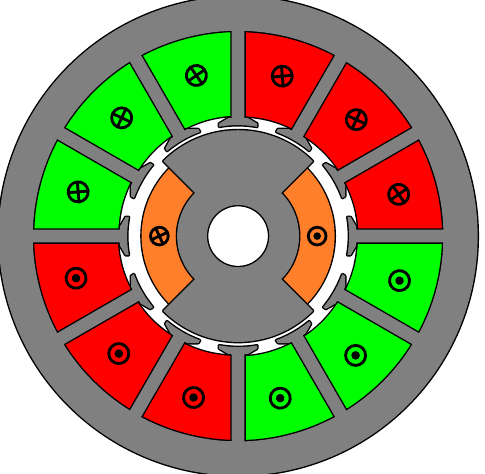
Figure 22. Full pitch winding slotted resolver with twelve